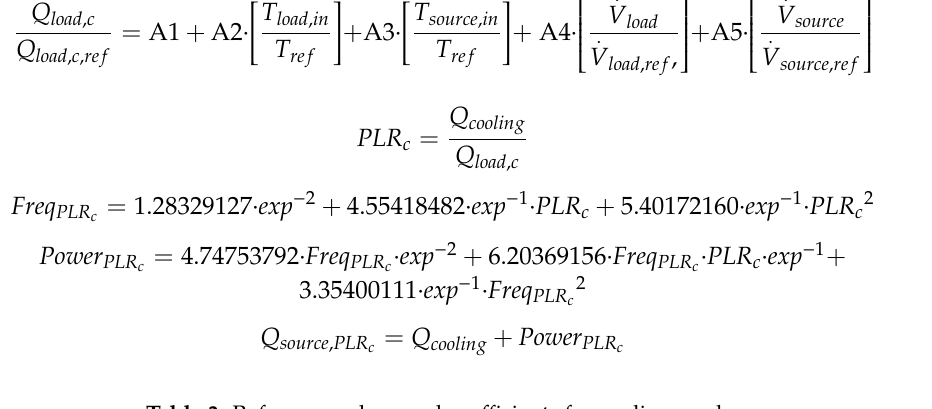
Table 3. Reference values and coe ffi cients for cooling